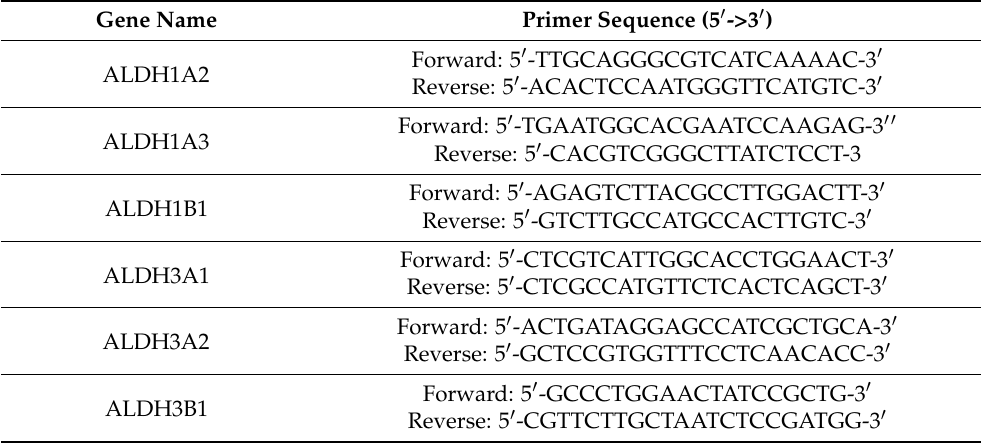
Table 1. Sequences of primers used in the polymerase chain